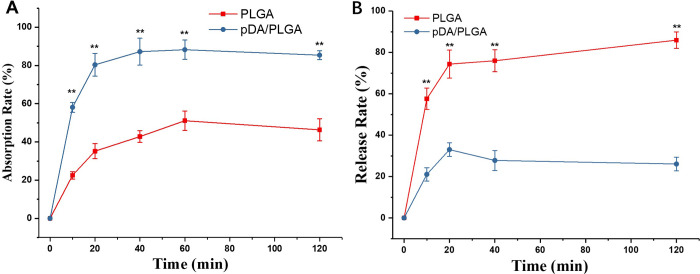
Kinetics of growth factor absorption and release.The quantitative (A) absorption and (B) release tests based on ELISA method. **p<0.01.